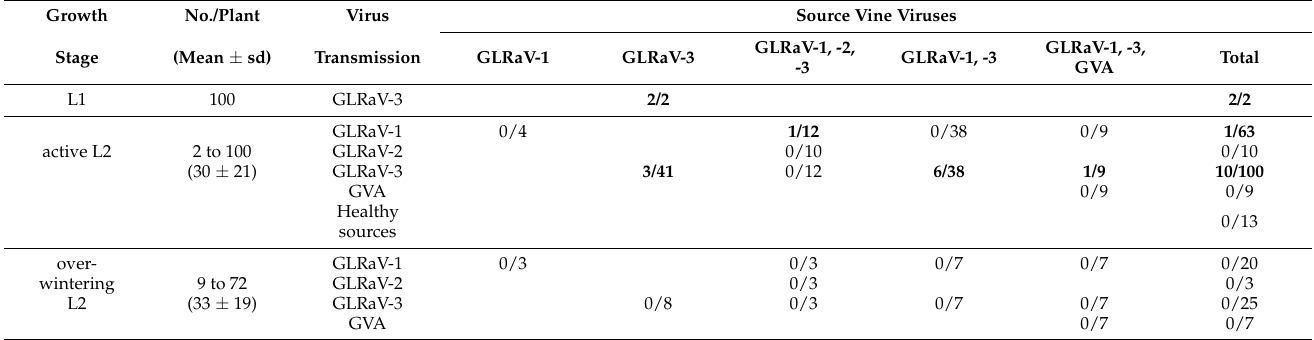
Table 6. Transmission rates in infectivity experiments with Heliococcus bohemicus nymphs from Bennwihr, according to virus combinations in source plants. (Number of positive vines/number of inoculated recipient vines). Virus transmissions are highlighted in